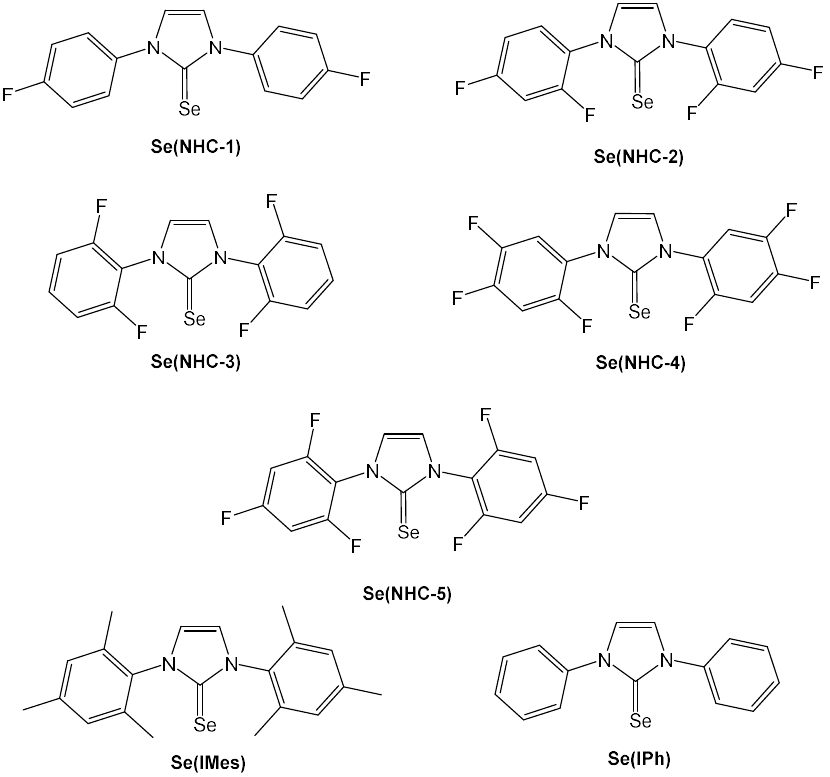
Figure 4. Selenium-NHC adducts prepared in this study; those containing fluorinated NHCs { Se(NHC-1) – Se(NHC-5) and the non-fluorinated analogues, Se(IMes) and